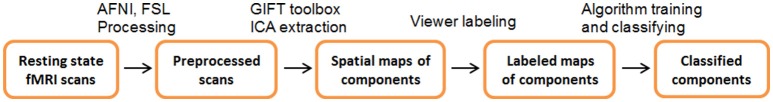
Extraction and Classification process. Flowchart of the steps involved in ICA map extraction and classification.